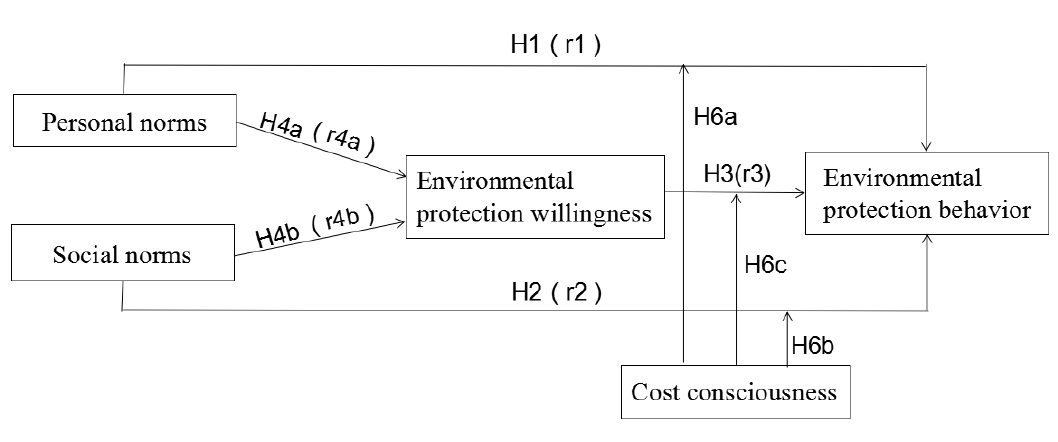
Figure 1. Theoretical model.